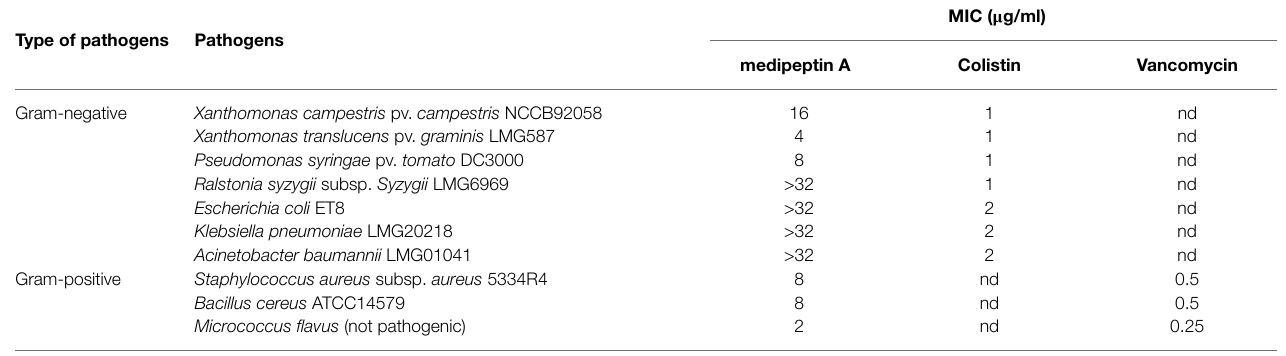
TABLE 3 | MIC value of medipeptin A against pathogenic bacteria.